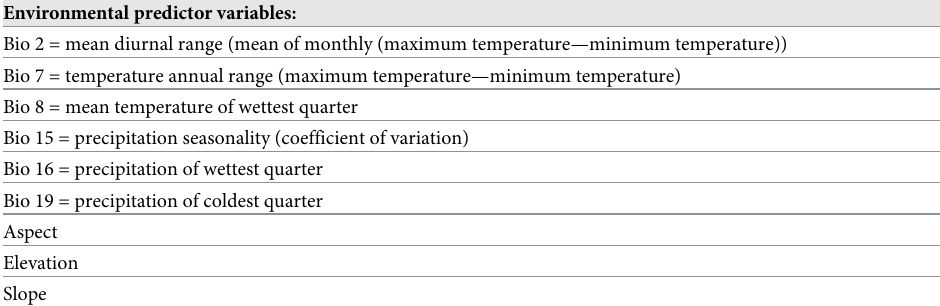
Table 2. Environmental variables derived from monthly temperature and rainfall values. The variables were selected from the WorldClim 2 database to generate dryland-farming MaxEnt models. All the environmental variables analyzed for the study can be found in (S4